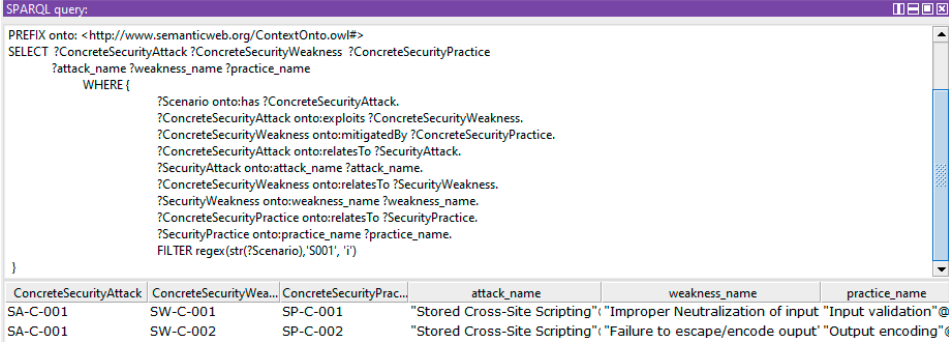
Figure 10. An example of SPARQL (to query security knowledge).